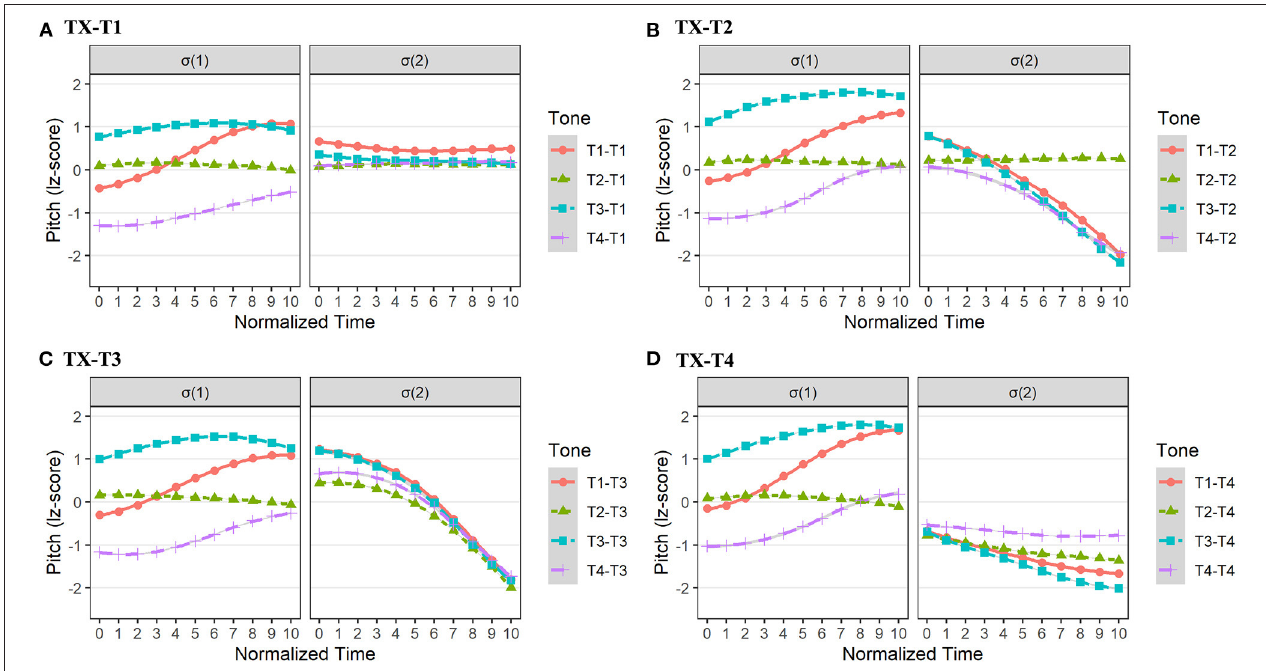
FIGURE 5 | The pitch realizations of σ (1) and σ (2) in Chengdu dialect with tonal combinations of TX-T1 (A) , TX-T2 (B) , TX-T3 (C) , and TX-T4 (D) .